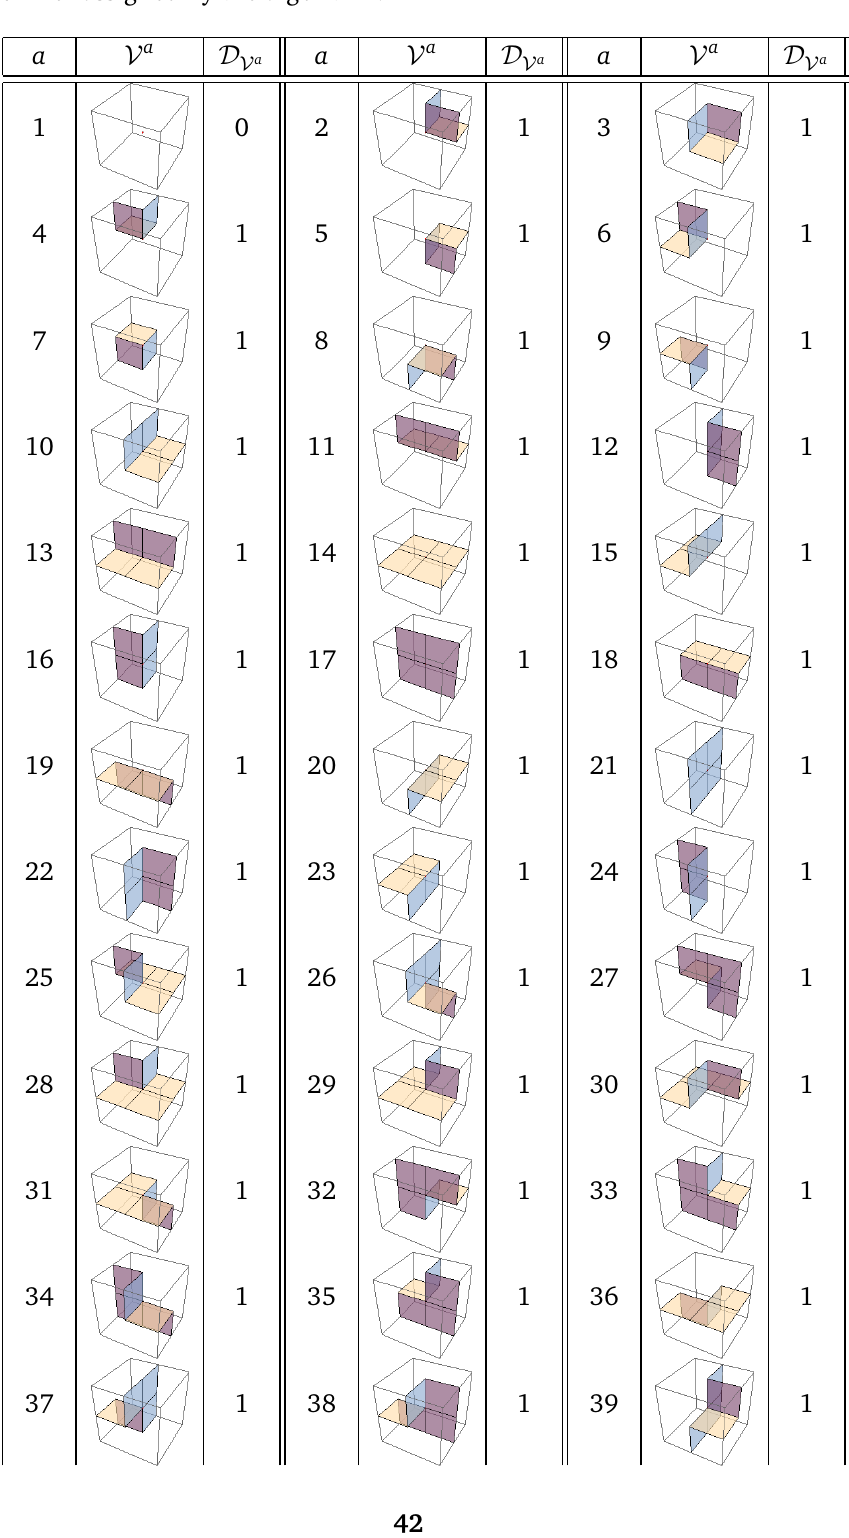
returns the ver- V a